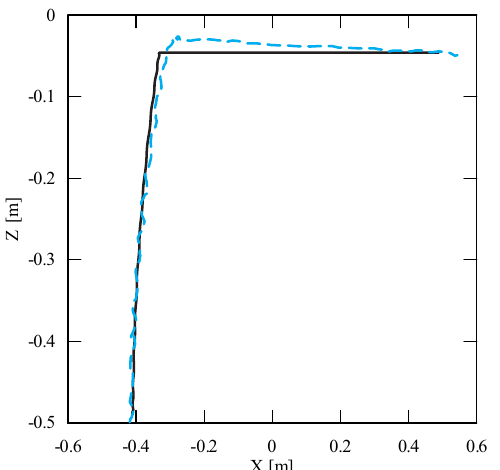
Figure 16. Projection of the trajectory of the transferred load in the lifting plane XZ (solid line— numerical calculations; dashed line—experiment results).